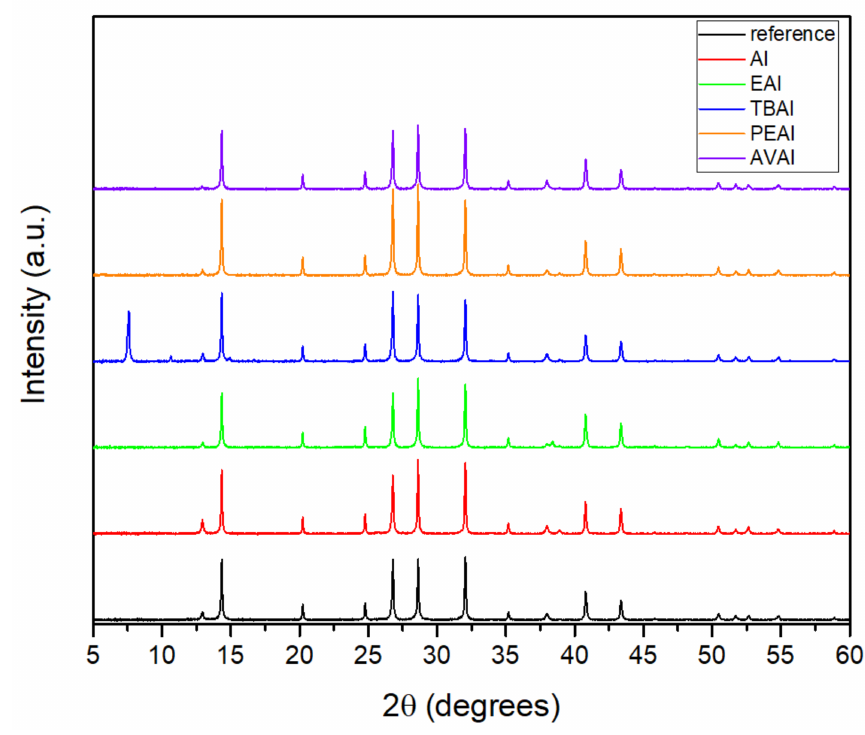
Figure 9. X-ray diffraction patterns of the perovskite films prepared without and with the ammonium iodide